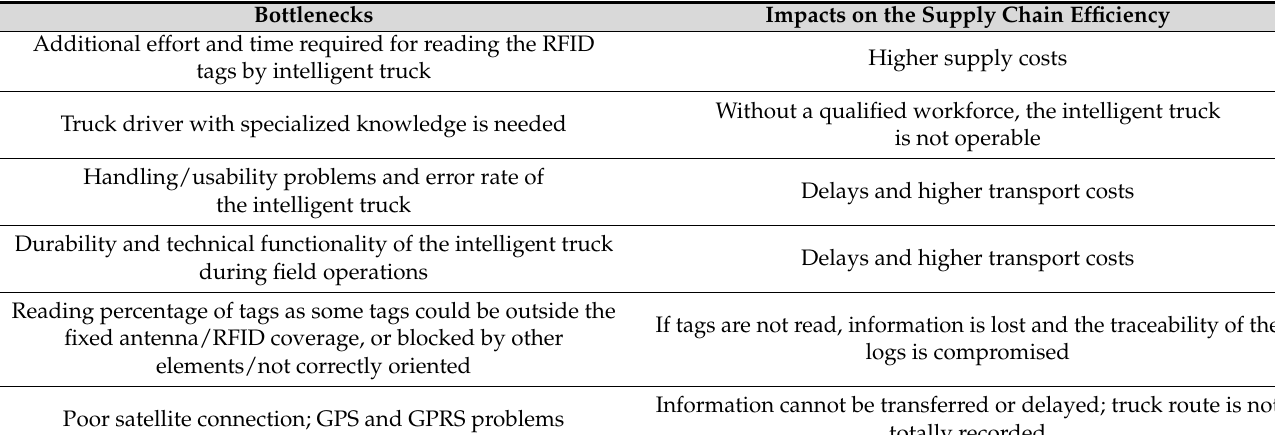
Table 9. Bottleneck analysis of transporting logs by intelligent truck.